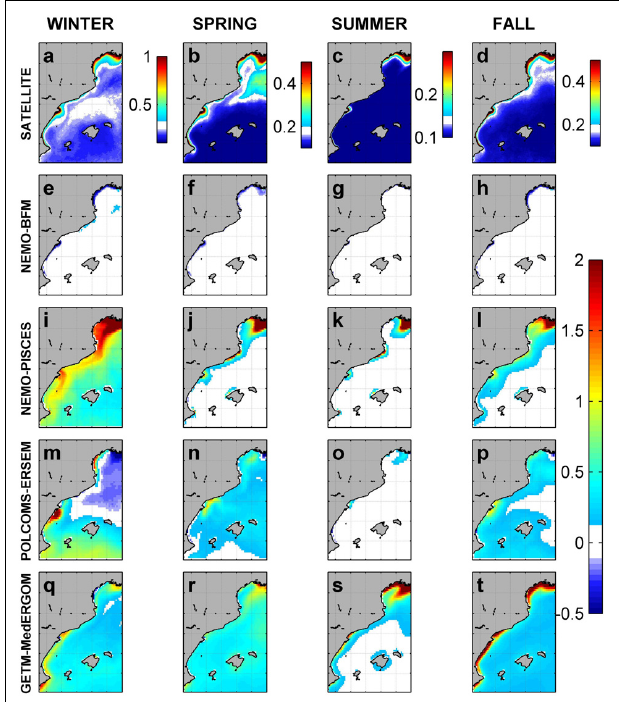
FIGURE 7 | Average seasonal pattern of surface chlorophyll- a a derived from satellite and difference with the four models (mg m - 3 ). Satellite (a–d) , NEMO-BFM (e–h) , NEMO-PISCES (i–l) , POLCOMS-ERSEM (m–p) , and GETM-MedERGOM (q–t) .